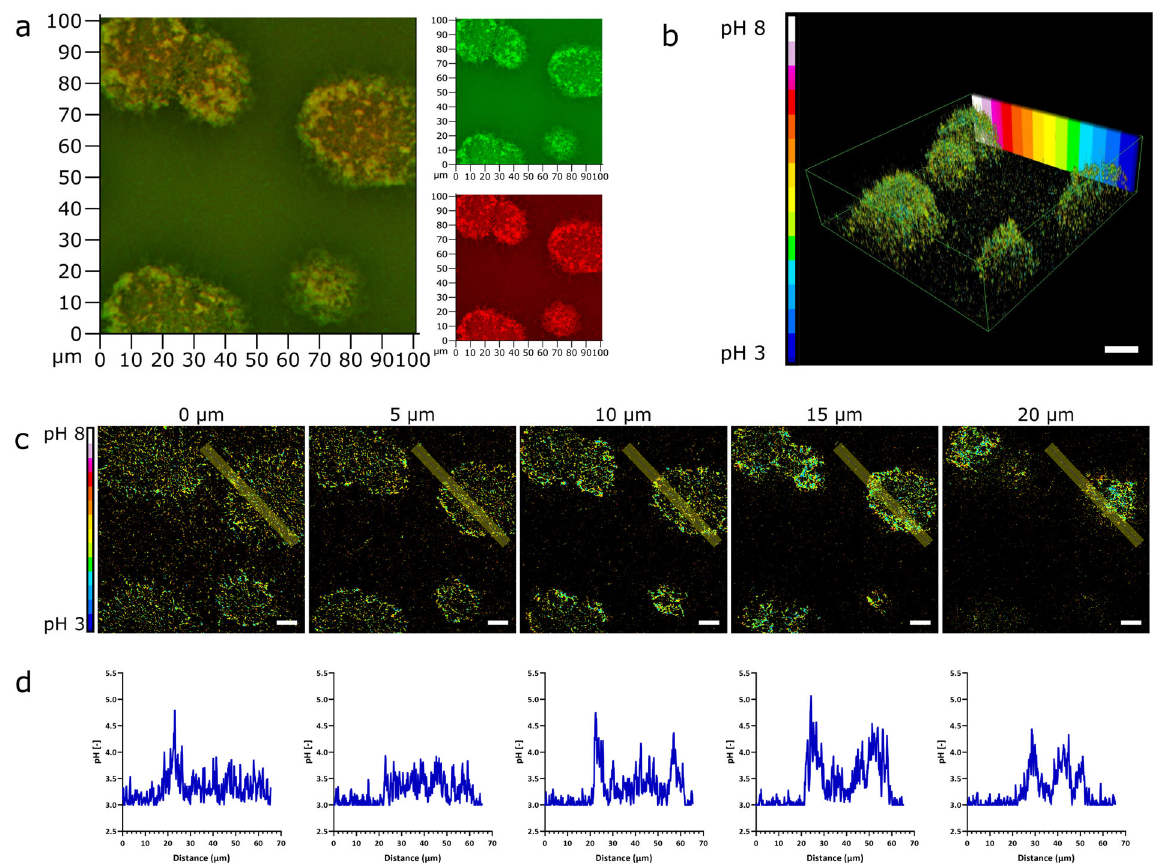
Fig. 5 P. aeruginosa microcolonies in fl ow bio fi lms have an acidic centre. a The confocal 3D Z -stack image of a representative single microcolony from a P. aeruginosa bio fi lm grown in a BioFlux fl ow cell system with 5 mg mL − 1 neutral charged pH-sensitive polyacrylamide nanosensors ( fl uorescence overlay, OG-FAM fl uorescence in green, TAMRA fl uorescence in red). The pH variation was observed after bio fi lm growth for 22 h. MatLab and ImageJ analysis of confocal images shows a lower pH of 3.5 – 4.0 within the core of microcolonies and a higher pH of 5.5 – 6.0 at the outer parts. Images represent 3D rendering of the bio fi lm Z -stack ( b ) and individual pH maps at the bottom of the bio fi lm (0 µm) and 5, 10, 15 and 20 µm from the bottom into the bio fi lm ( c ). Plot pro fi les of a straight line highlighted within the pH maps were created using ImageJ ( d ). Scale bars represent 10